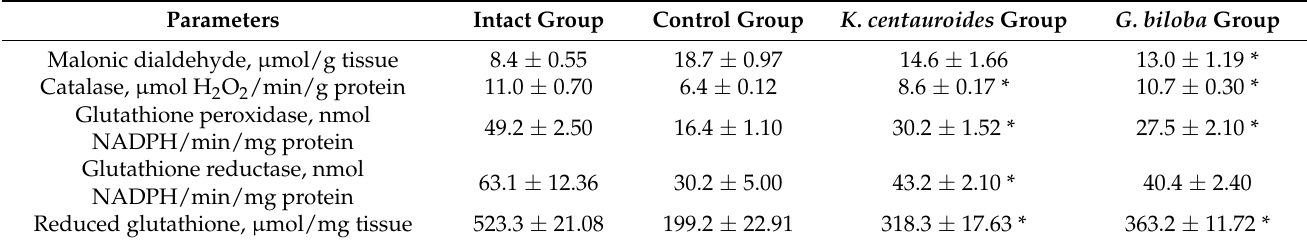
Table 5. Malonic dialdehyde level, catalase, glutathione reductase, glutathione peroxidase actions and reduced glutathione level in the rats’ brain with prolonged scopolamine